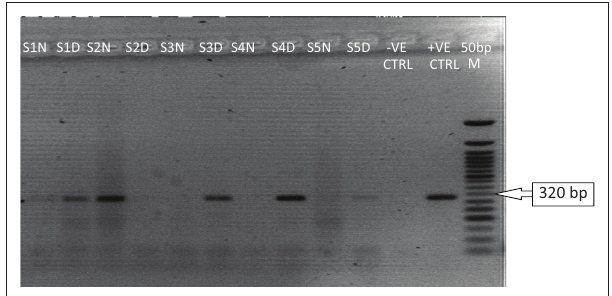
bp, base pair. FIGURE 1: Reverse transcription polymerase chain reaction detection of S gene fragment of the Lassa virus, Lagos, Nigeria, March 2018. The gel lanes represent neat (undiluted, N) and 1:10 dilutions (D) of the RNA extracts used. Three Nigerian outbreak samples representing lanes S1–S3 (accession numbers: MF317933-35) were run alongside Benin Republic outbreak samples (S4–S5). RNase/DNase free water was used as a negative extraction control (-VE CTRL)